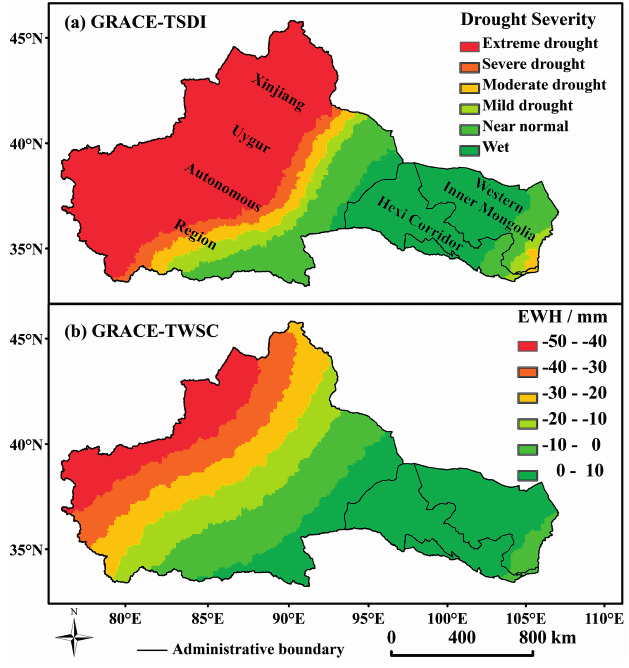
Figure 11. Spatial distributions of TSDI-derived drought conditions and average TWSC in the arid land of northwestern